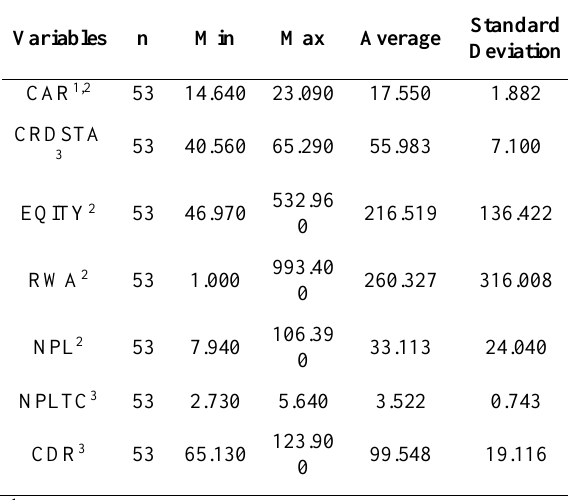
Table 2: Details of Independent